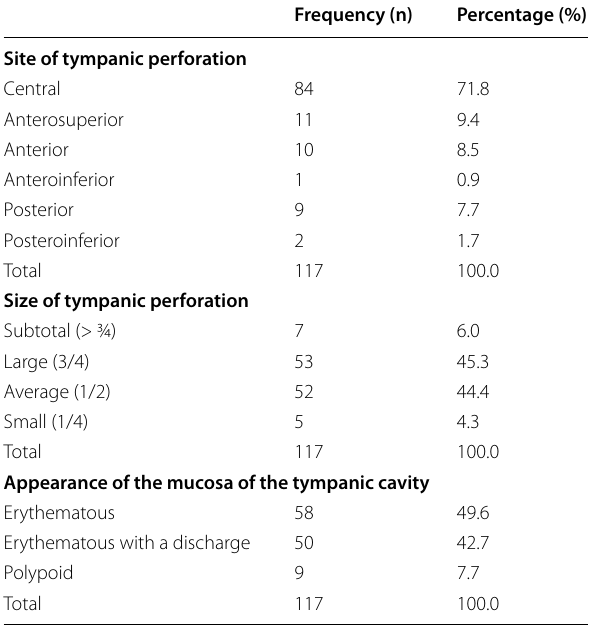
Table 2 Otoscopic profile of the 117 ears Table 3 Correlation between tympanic perforation size, tympanic mucosal appearance and duration of chronic